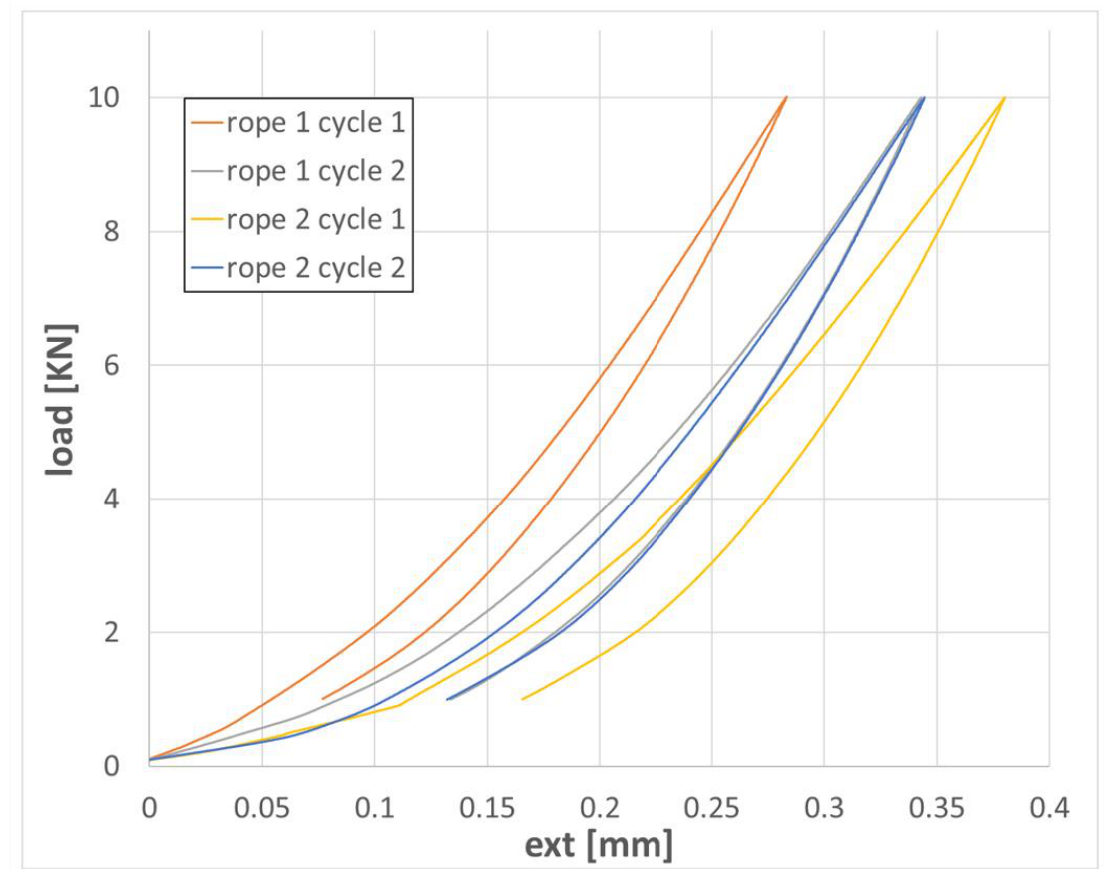
Figure 22. Load versus displacement curves of the tested guy-wires.